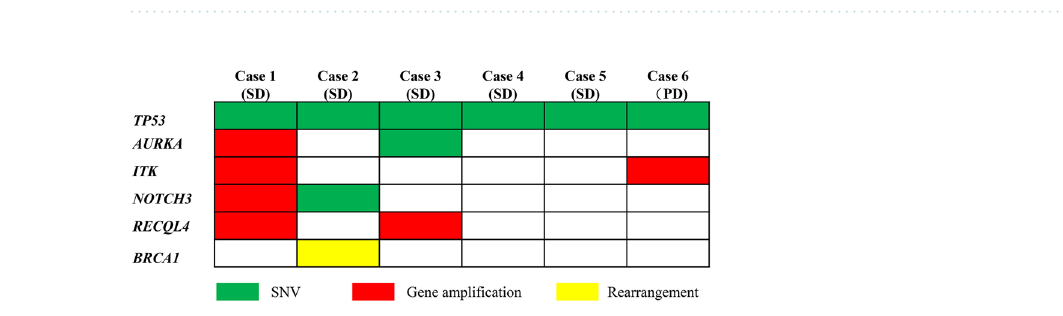
Figure 3. Different molecular characteristics of high-grade serous ovarian cancer patients in China and Western countries. ( A ) Differences of somatic mutations between Chinese and Western patients. ( B ) Differences of germline mutations between Chinese and Western patients. The X-axis shows the mutated genes and the Y-axis represents the mutational frequency of genes. Fisher’s exact test was used to analyze significant differences. ns P > 0.05, ** P < 0.01, and *** P < 0.001.